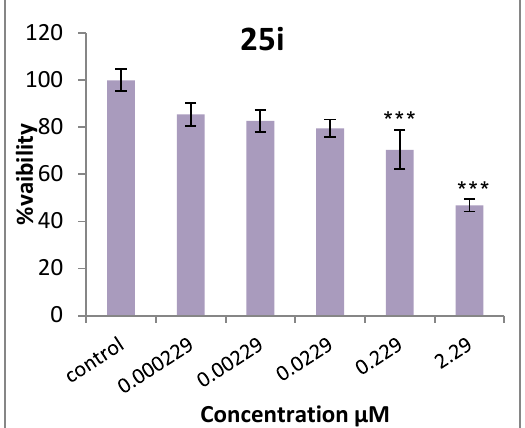
Figure 2. Cytotoxic effect of compounds 25i , 25j against the proliferation of MCF-7 breast cancer cells. Cells were treated with the indicated doses and cell viability was obtained using MTT cell viability assay. *** p < 0.001 calculated by comparing each concentration with the control. The data were normally distributed and were expressed as the mean ± standard error of the mean (SEM). Two-tailed paired student test p -values as determined by Graphpad Prism software is indicated as *** p < 0.001.